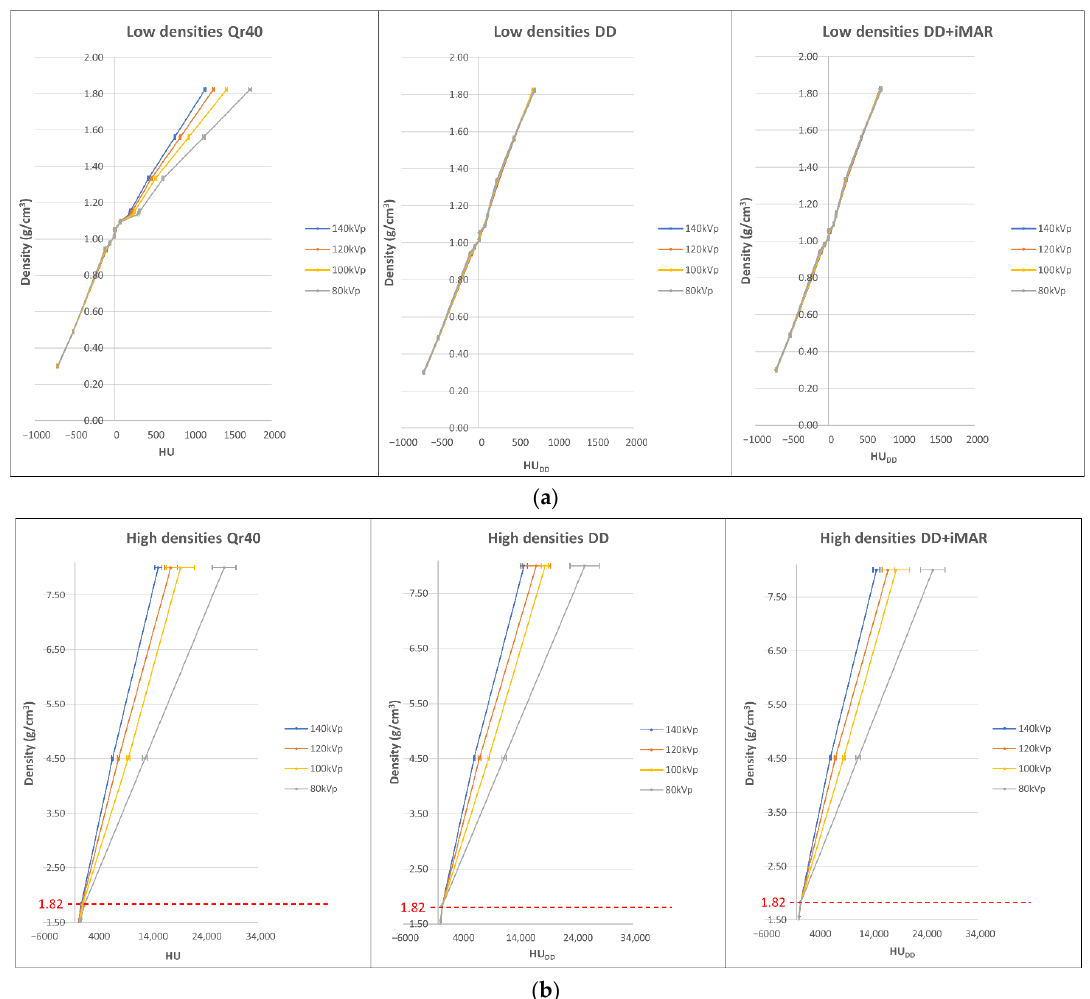
Figure 6. ( a ) The mean calibration curves at densities up to 1.82 g/cm 3 associated with the three different convolution kernels (Qr40 on the left, DD in the middle, and DD + iMAR on the right) used during the reconstruction of the Cheese phantom CT scans with or without the metal inserts. Curves associated with each kVp value, given a convolution kernel, were obtained by averaging the mean HU (or HU DD ) value in each ROI over the acquisitions with and without the metal inserts in the Cheese phantom, at the same kVp value. ( b ) The mean calibration curves at densities ranging from 1.82 g/cm 3 to 8 g/cm 3 associated with the three different convolution kernels (Qr40 on the left, DD in the middle, and DD + iMAR on the right) used during the reconstruction of the Cheese phantom CT scans with the metal